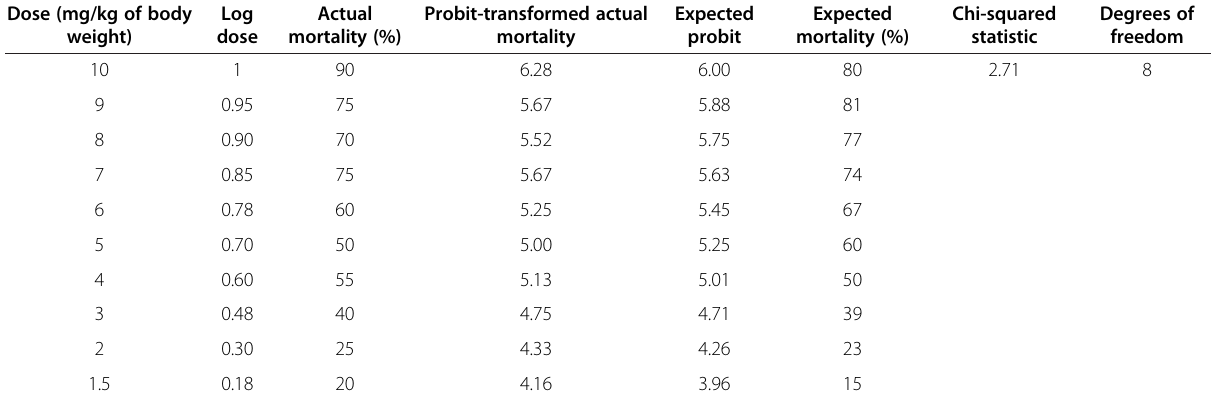
Table 1 Analysis of probit-transformed mortality of European hornet Vespa crabro workers provoked by their own venom Dose (mg/kg of body Log weight) dose